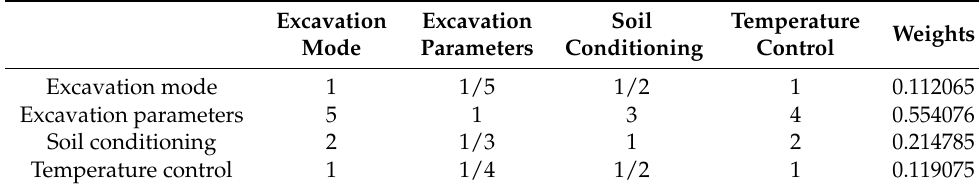
Table A2. Pairwise comparison matrix for tertiary level operational factors (b3-c). λ max = 4.0155; CR = 0.00581; CI =